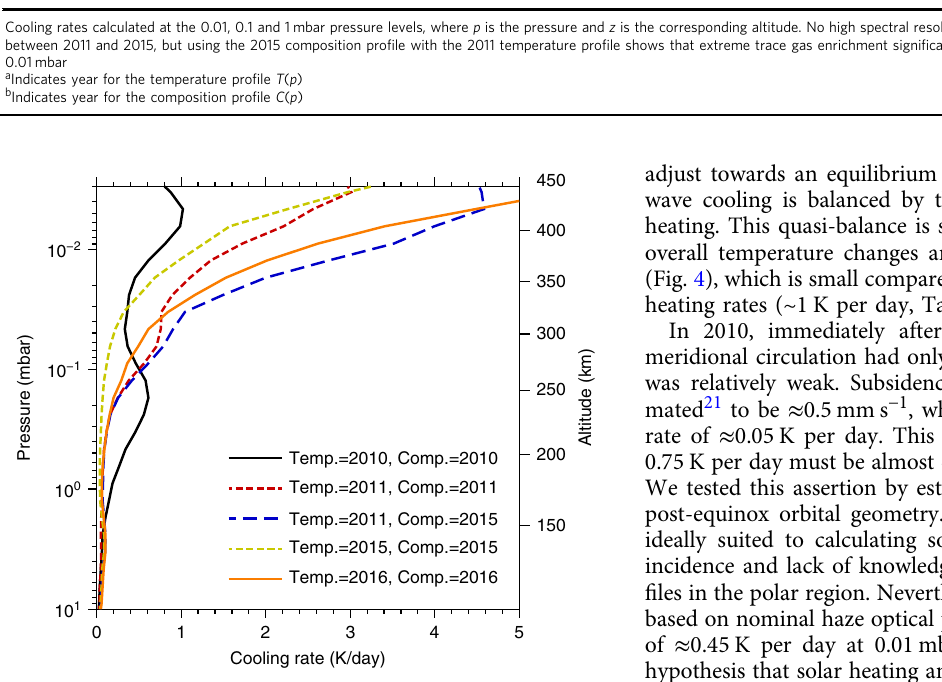
Fig. 7 Long-wave radiative cooling rates calculated using the measured temperature and composition pro fi les within the south polar